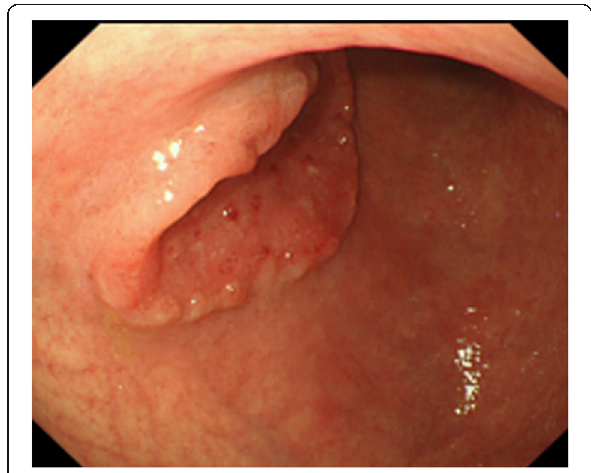
Fig. 1 Endoscopy showing type 2 tumor measuring 50 mm at the anterior wall of the lower third of the stomach